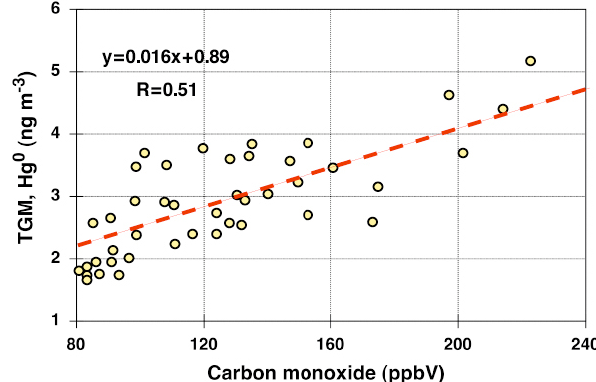
Figure 9 . Scatterplot of TGM, Hg 0 vs. CO observations during the August 2-3 pollution episode. The equation of the linear fit as well as the correlation coefficient are displayed. Fig. 9. Scatterplot of TGM, Hg 0 vs. CO observations during the 2–3 August pollution episode. The equation of the linear fit as well as the correlation coefficient are